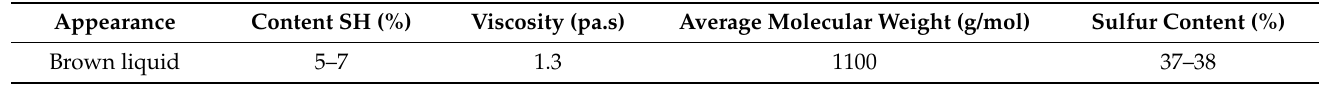
Table 1. Technical properties of used polysulfide.